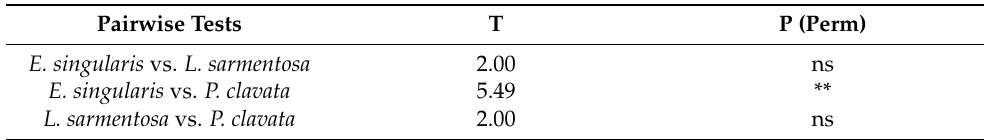
Table 3. Results of the pairwise tests contrasting the percentages of fed polyps of the three species across several temporal scales.